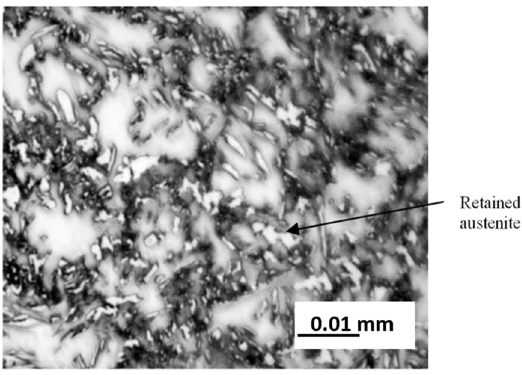
Figure 6. Microstructure of multiphase steel, variant no 2.